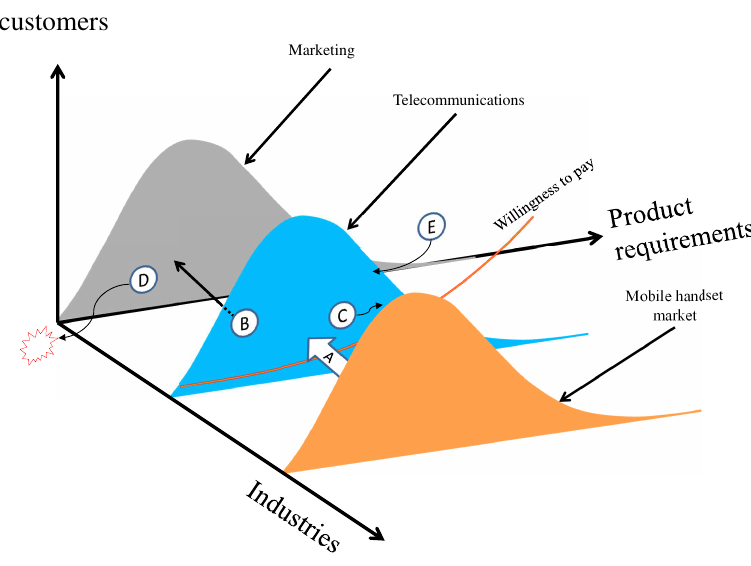
Fig 6. Technological diffusion from an industry to another (after Kilkki et al., 2017) In conclusion, the disruption framework is useful when applied to the ecosystem of some wider phenomena. Examples presented in this paper are just indications of compatibility to the framework. The model can be used for modelling the process that may lead to a disruption. The model can also be used to understand temporal dimension of the technology diffusion within an